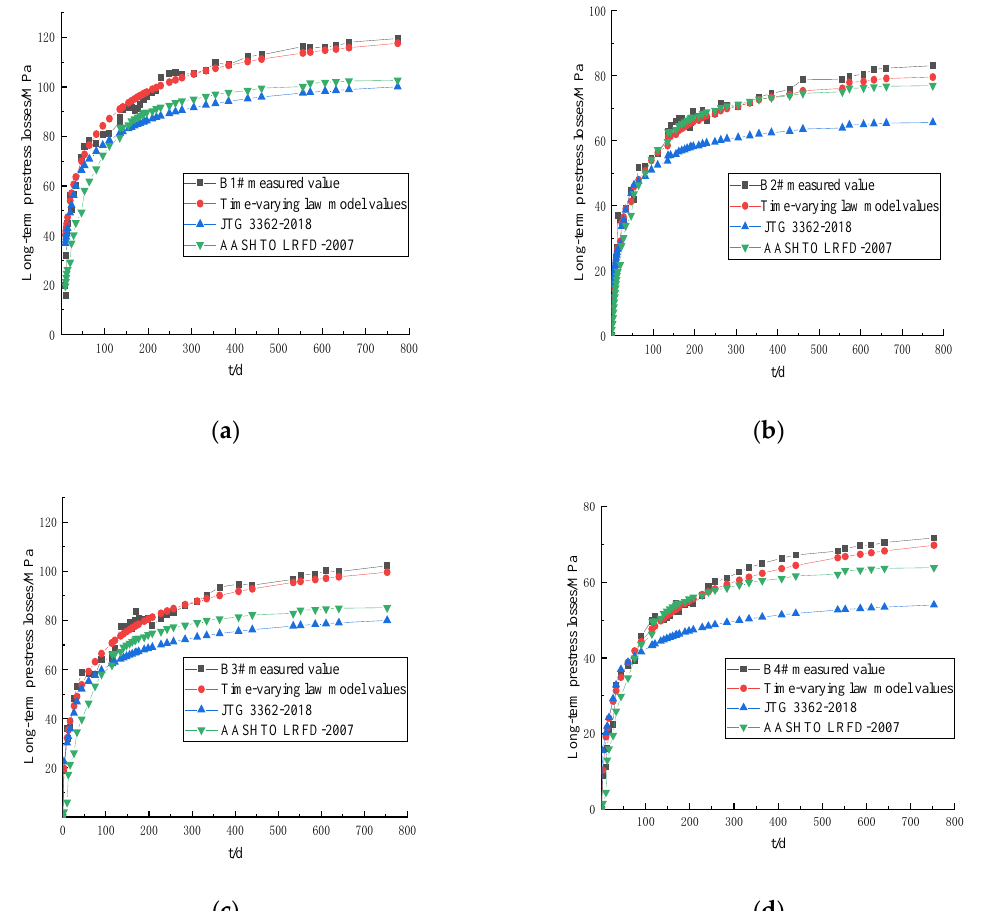
Figure 8. Comparison of the measured values of the long-term prestress losses of the test T-beams and the calculation results: ( a ) B1#; ( b ) B2#; ( c ) B3#; ( d ) B4#.